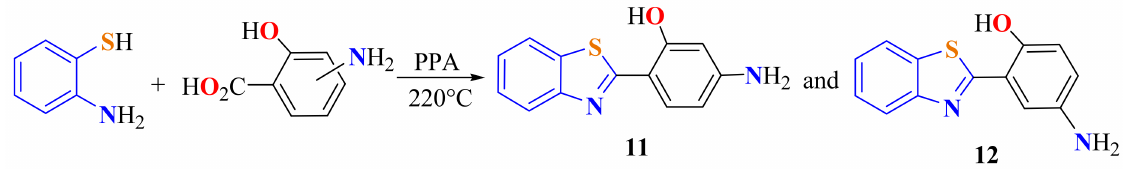
Mathis et al. condensed 5-MeO-ATP with p -(methylamino)benzoic acid in PPA